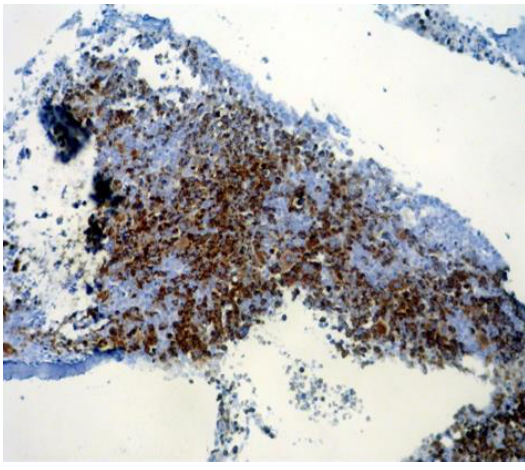
Fig 3 . α-synuclein staining in AML-M6; all of the erythroid precursors and few scattered megakaryocytes are positive, whereas non-crythroid blasts are negative